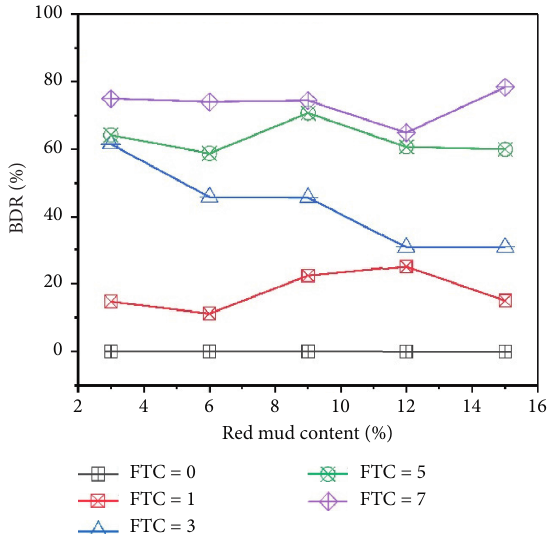
Figure 7: The relationship between BDR and red mud content.